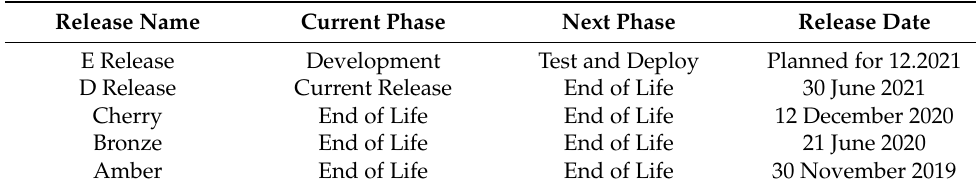
Table 2. O-RAN SC releases (according to-O-RAN SC Wiki